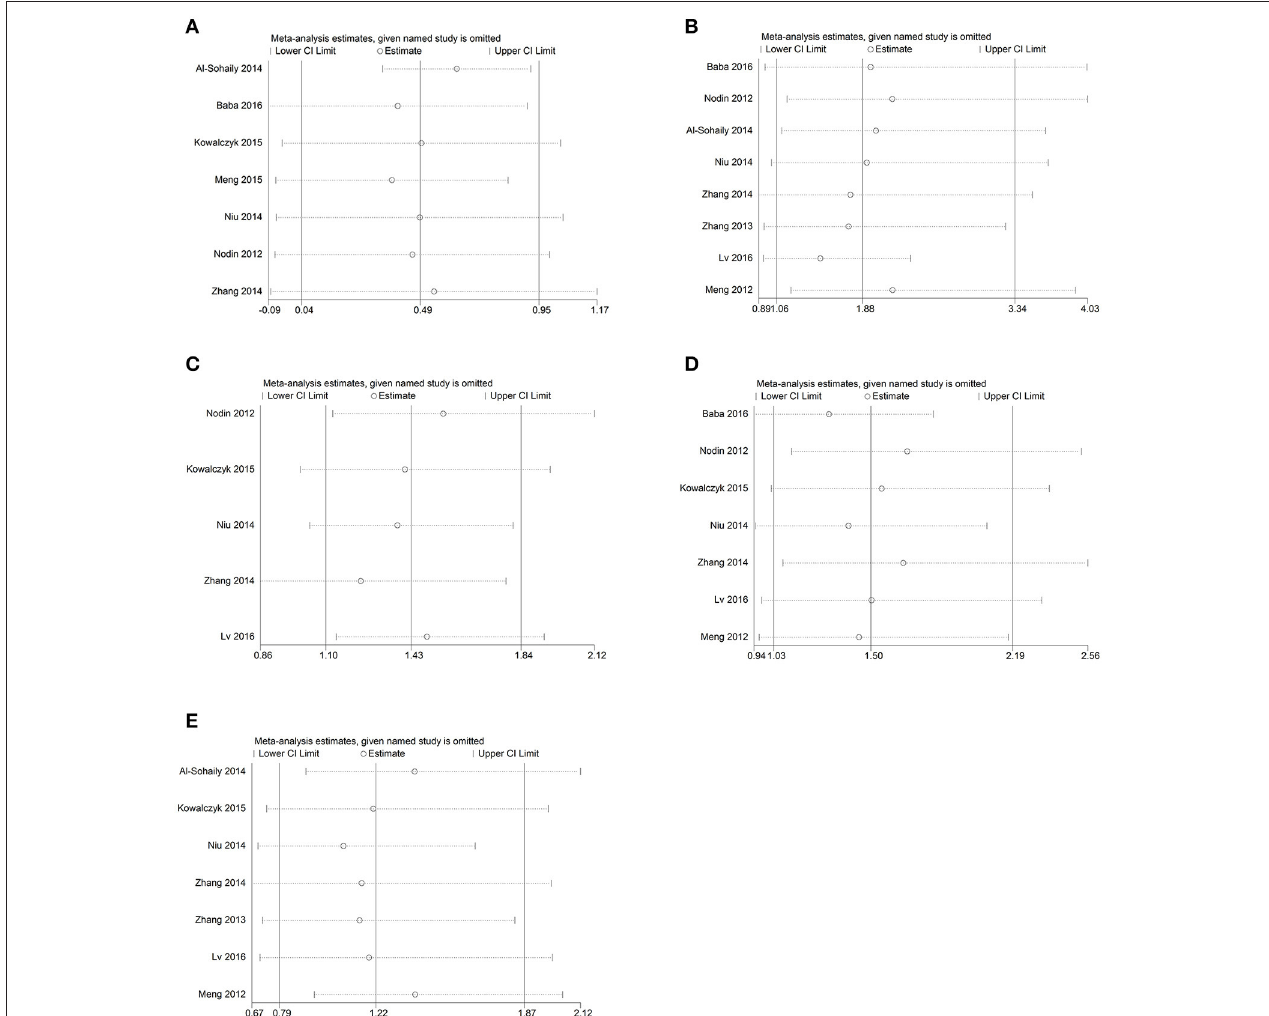
FIGURE 4 | Sensitivity analysis of the studies. (A) overall survival; (B) Histologic grade; (C) Distant metastasis; (D) Lymph node metastasis; (E) TNM stage.